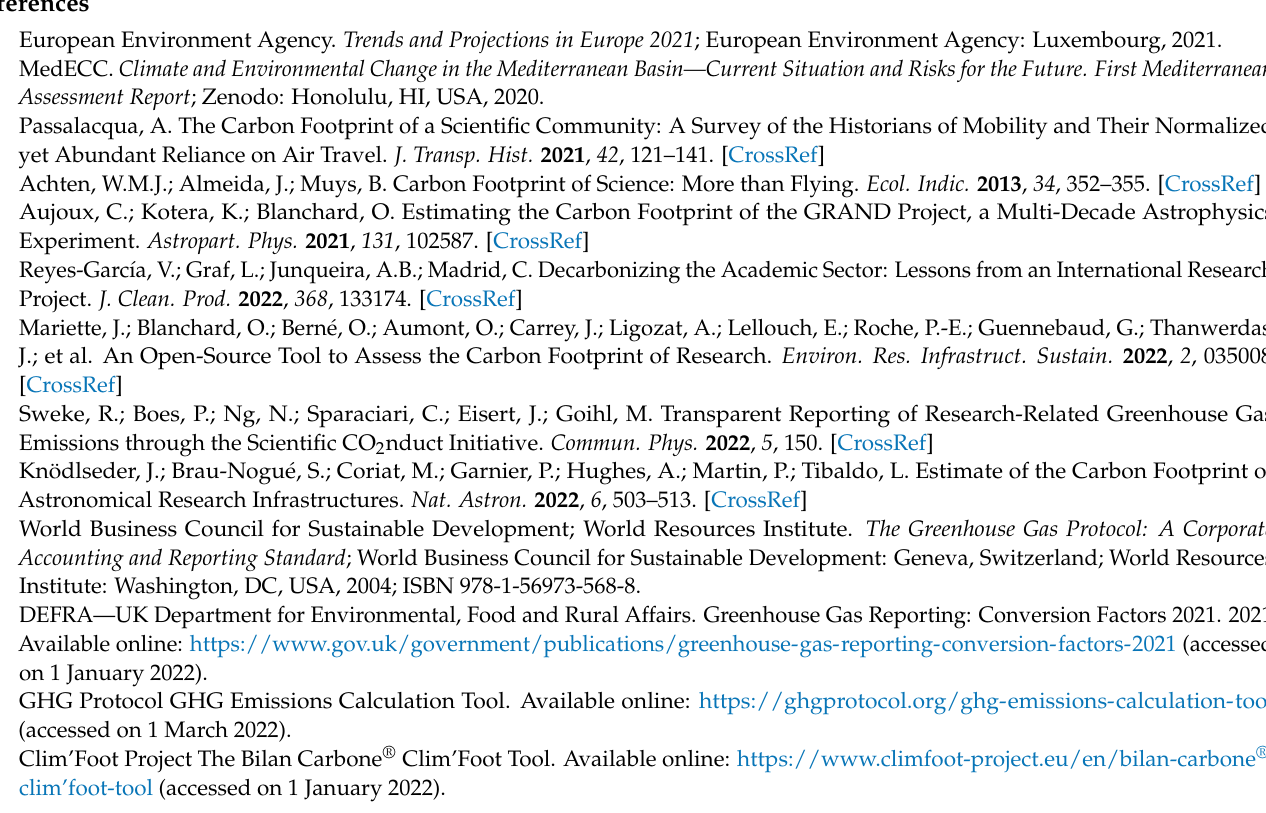
per employee in offices. Table S4: Percentage distribution (%) of materials wasted by type of disposal per country. Table S5: Percentage distribution (%) of food and drink wasted by type of disposal. Table S6: Percentage distribution (%) of international/national travels in Europe by transport mode. Table S7. Percentage distribution of travels by main travel mode (car, motorbike, bus, taxi, national rail, light rail and tram/underground, cycling, walking and